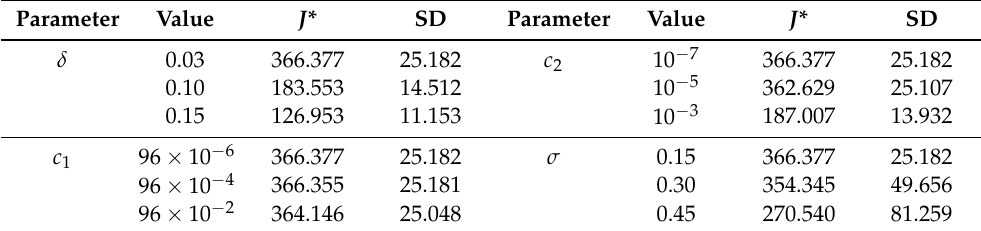
Table 3. Alternative parameter values for model GL ( 1,2,3 ) . The parameters used to perform the sensitivity analysis were δ , c 1 , c 2 and σ . Profit and standard deviation values are in millions of US dollars. SD represents standard